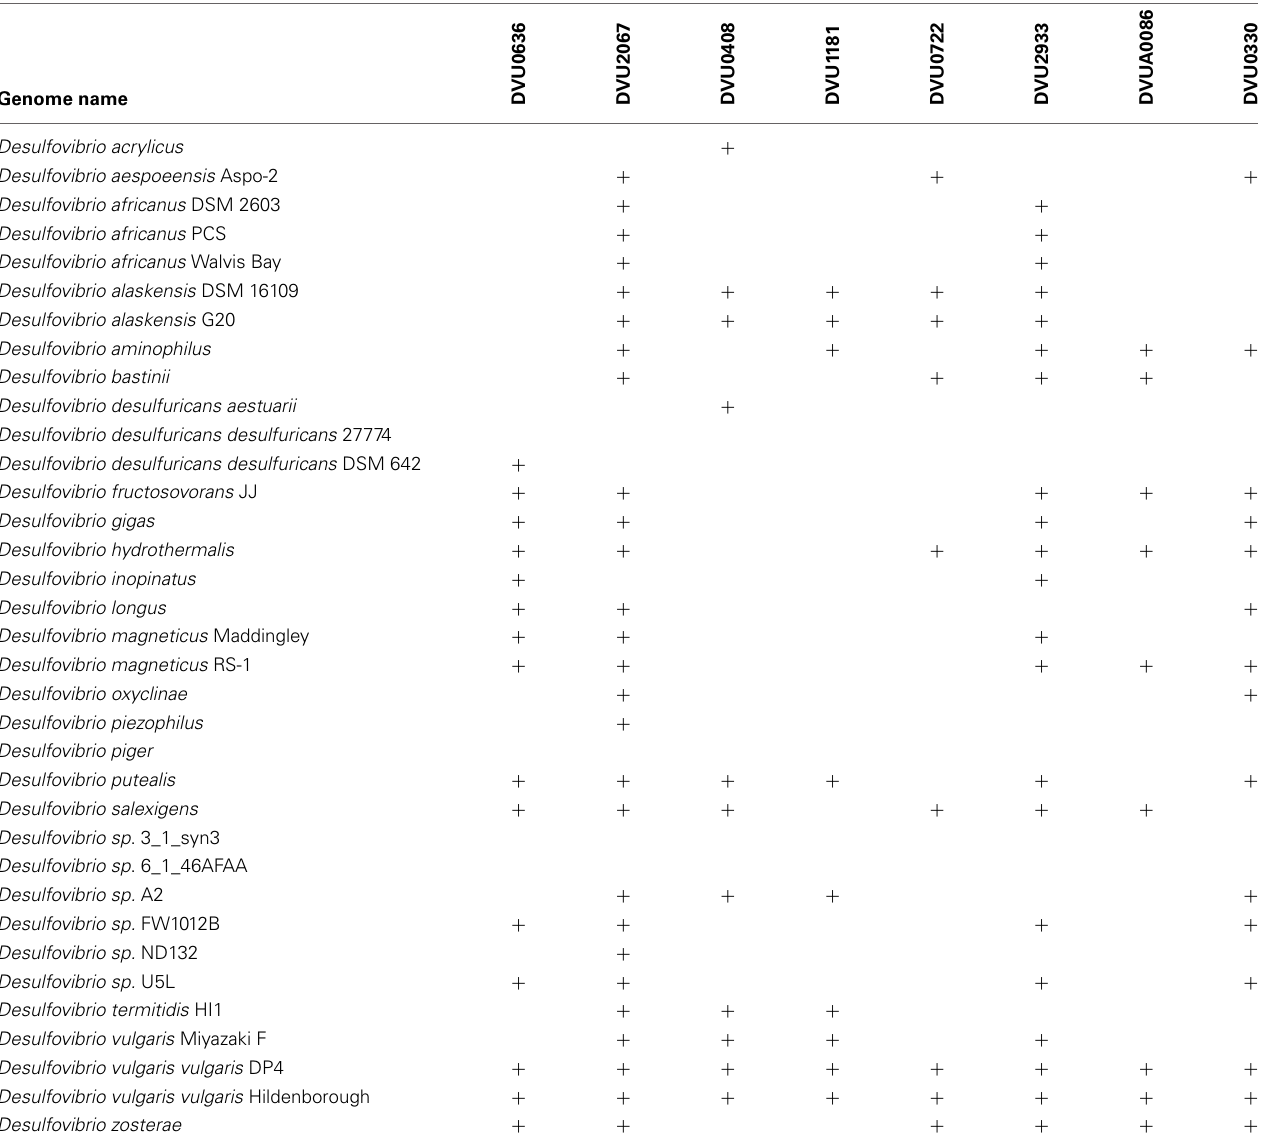
Table 2 | Conservation of RRs across sequenced Desulfovibrio